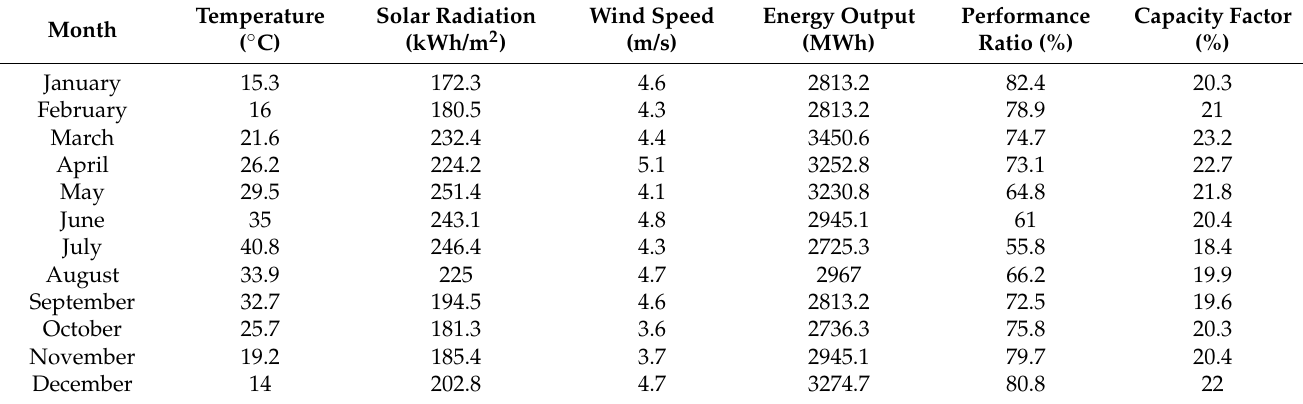
Table 16. Weather data and energy data measured and collected from the PV station during one